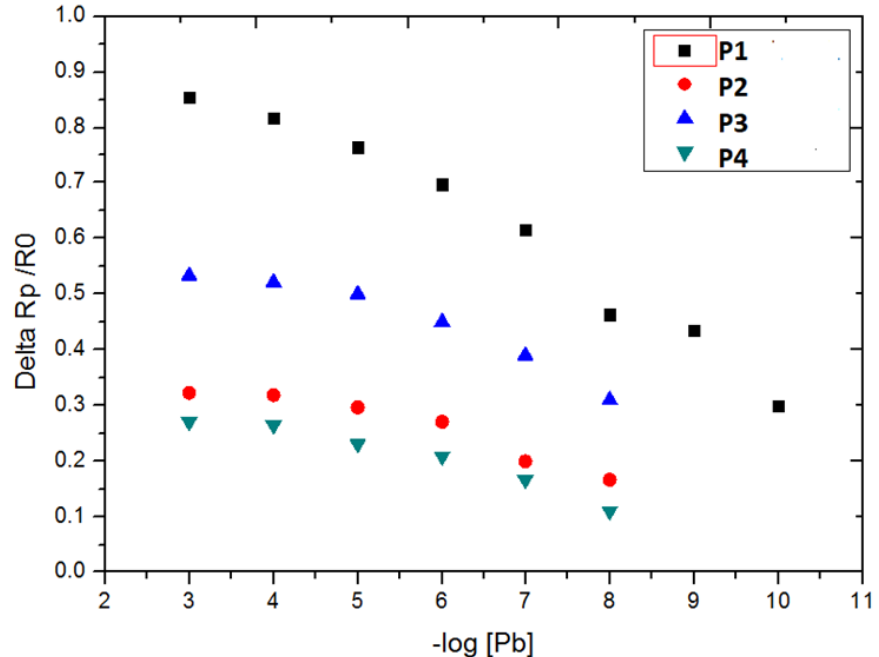
Figure 3. Relative variation of the polarization resistance of the polymer-modified gold electrode interface as a function of − log concentration of Pb 2 + ion (g / L). Table 2. Comparative study: responses of sensors based on P1–P4 polymers for the Pb 2 + ion. Sensing Polymers